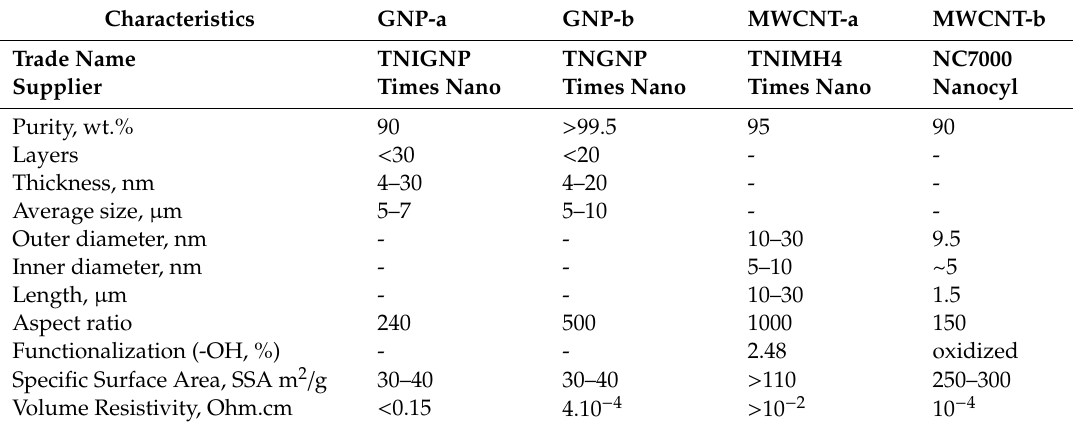
Table 1. Characteristics of the two types of carbon nanofillers, GNPs and